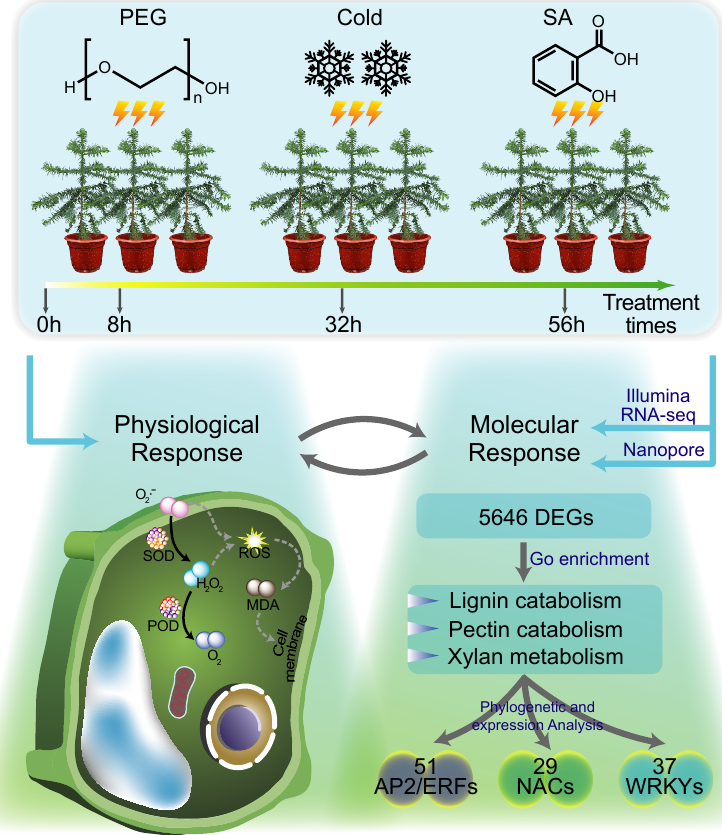
Figure 6. Model for stress responses in C. lanceolata